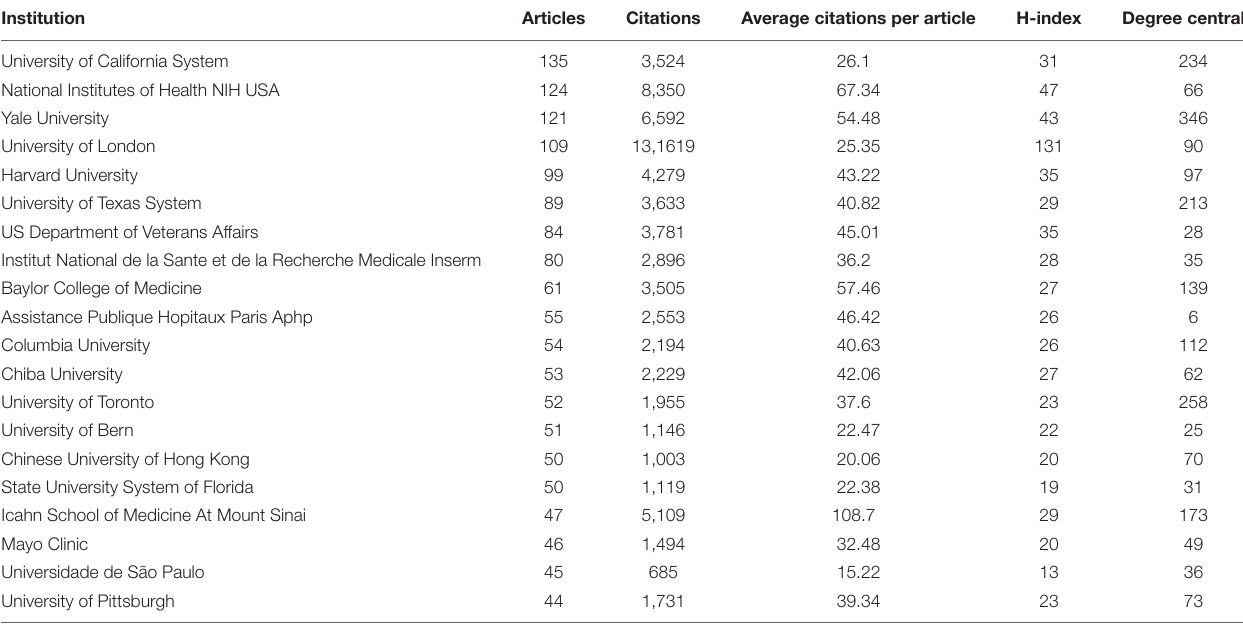
TABLE 3 | Top 20 author institutions in terms of number of articles